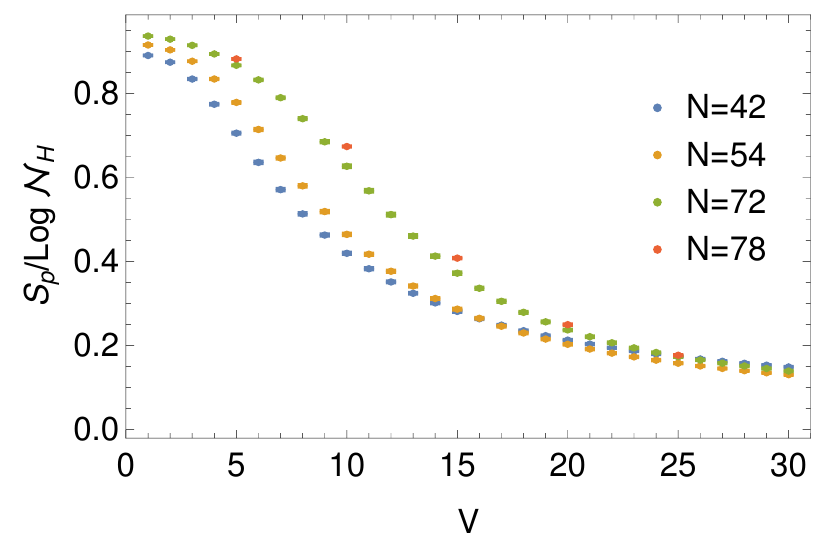
Figure 4: Eigenstates participation entropy rescaled by the logarithm of the Hilbert / ln N space size, S , as a function of disorder strength V and for different samples. p H V = 5 V = 10 V = 15